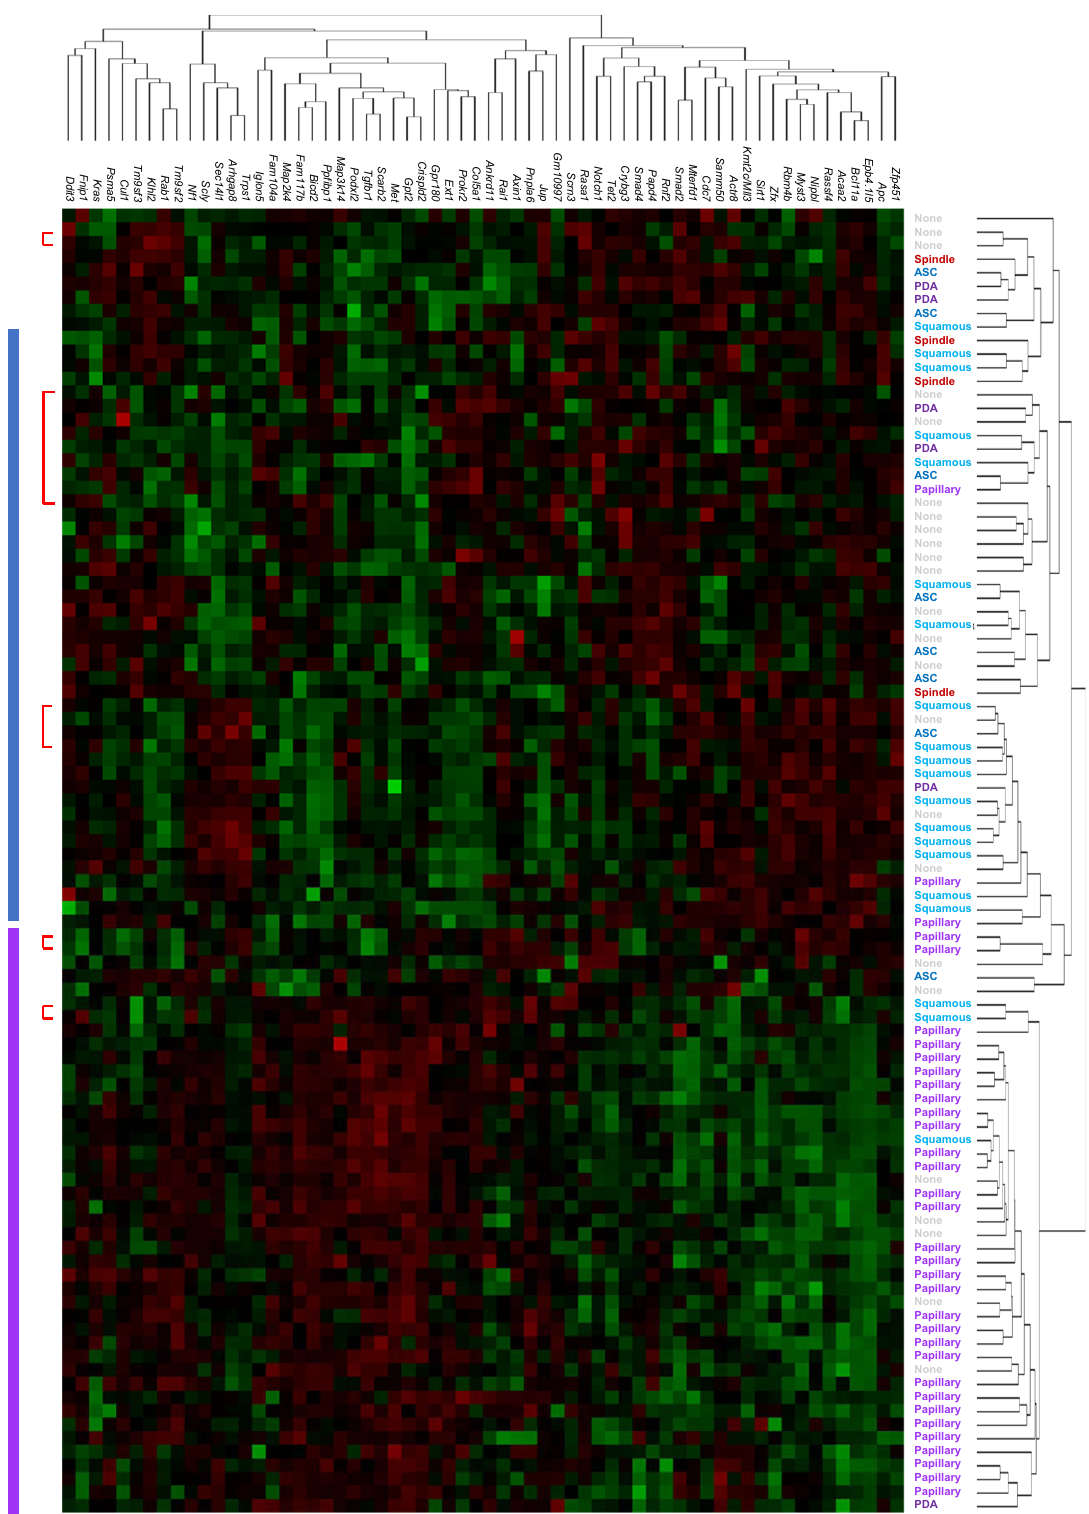
Fig. 7 Hierarchical clustering of Nanostring gene expression data reveals histology-speci fi c segregation of Rosa26- Pik3ca H1047R SB tumors on the basis of gCIS expression. Squamous and adenosquamous Rosa26- Pik3ca H1047R SB tumors segregate separately from papillary and PDA tumors when clustered on the basis of gCIS expression. Red brackets show technical replicates using the same RNA